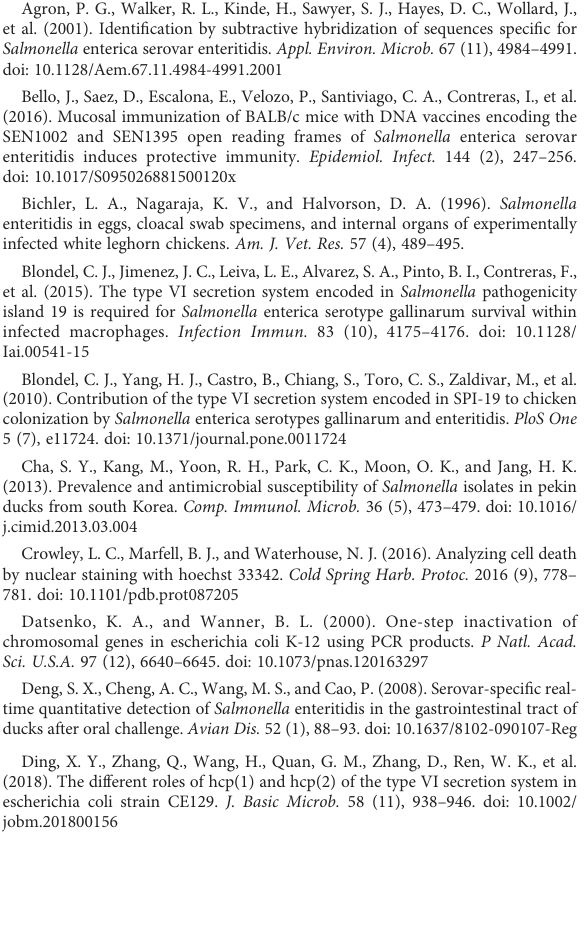
(A) The distribution of Peptide length; (B) The distribution of peptide number; (C) The distribution of protein molecular weight; (D) Protein function annotation; (E) Principal component analysis (PCA) to evaluate protein quantitative repeatability; (F) Relative standard deviation (RSD) to evaluate protein quantitative repeatability. SUPPLEMENTARY FIGURE S3 Peptide fragment ion peak area distribution of 11 differentially abundance proteins. SUPPLEMENTARY TABLE S1 The apoptosis and immune response between MY1-infected and MY1 △ hcp -infected dGCs. SUPPLEMENTARY TABLE S2 Basic information and statistics of MY1-infected and MY1 △ hcp -infected dGCs proteome. SUPPLEMENTARY TABLE S3 The statistics of differentially abundance proteins by proteomics between MY1-infected and MY1 △ hcp -infected dGCs. SUPPLEMENTARY TABLE S4 Quantitative veri fi cation of key proteins by parallel reaction monitoring technology